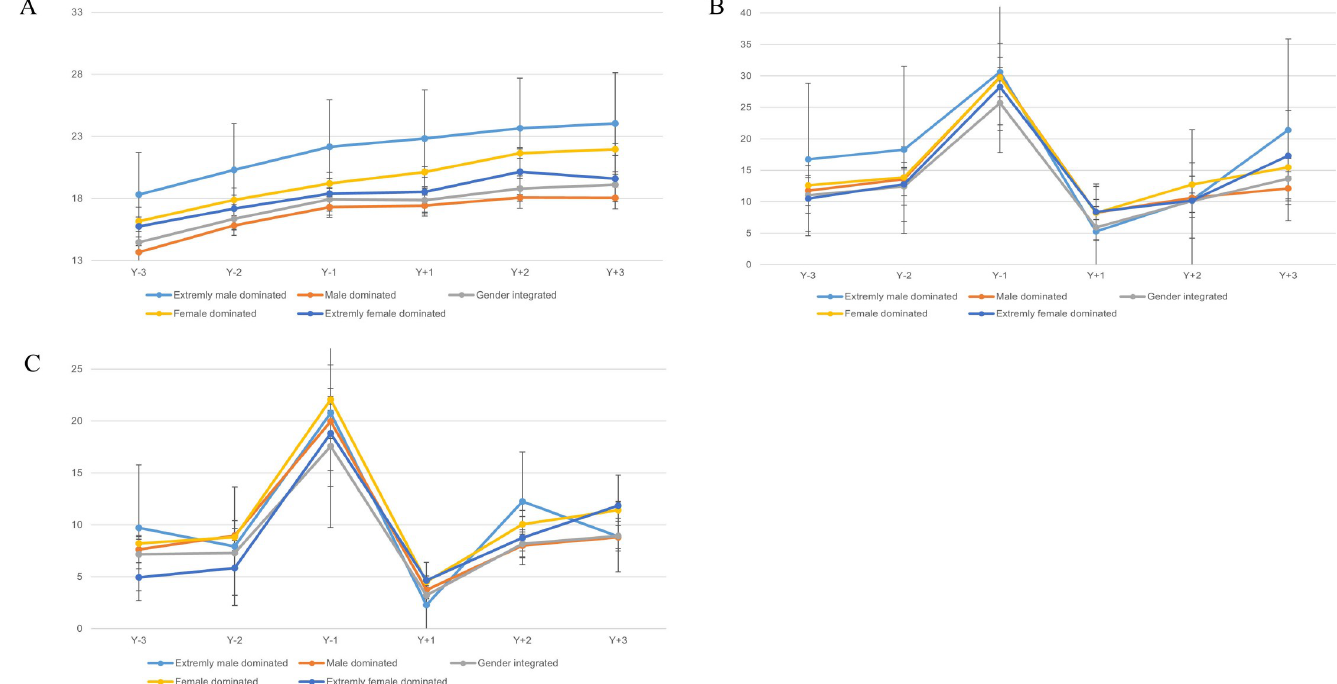
Fig 3. Standardized mean sickness absence (SA) and disability pension (DP) net days/year by occupational gender segregation category, and study year within each of the three childbirth groups (B0, B1, B1+).